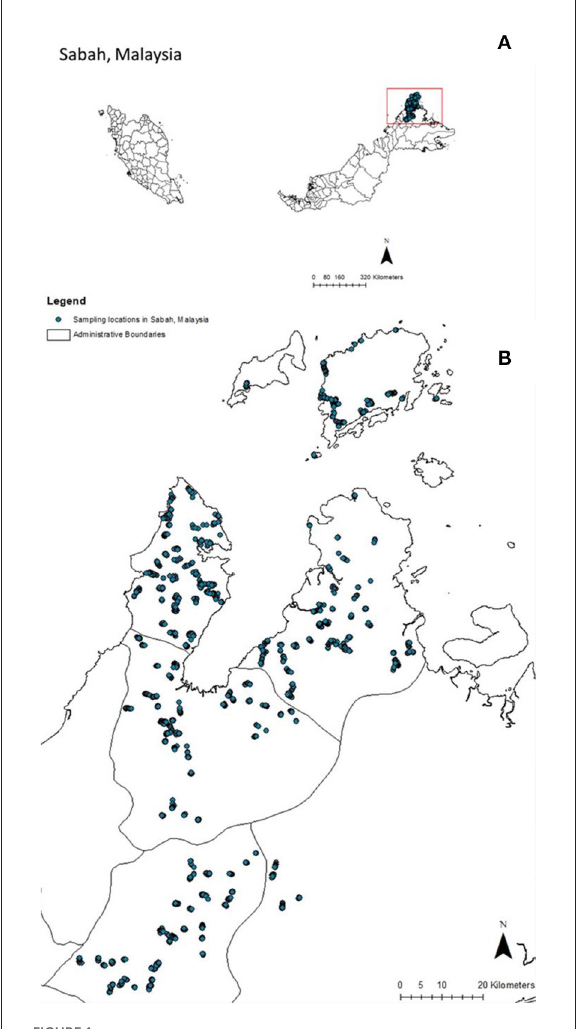
FIGURE1 Sampling sites in Sabah, Malaysia. Sampling site locations in Malaysia (A) and Sabah state in Malaysia (B) .